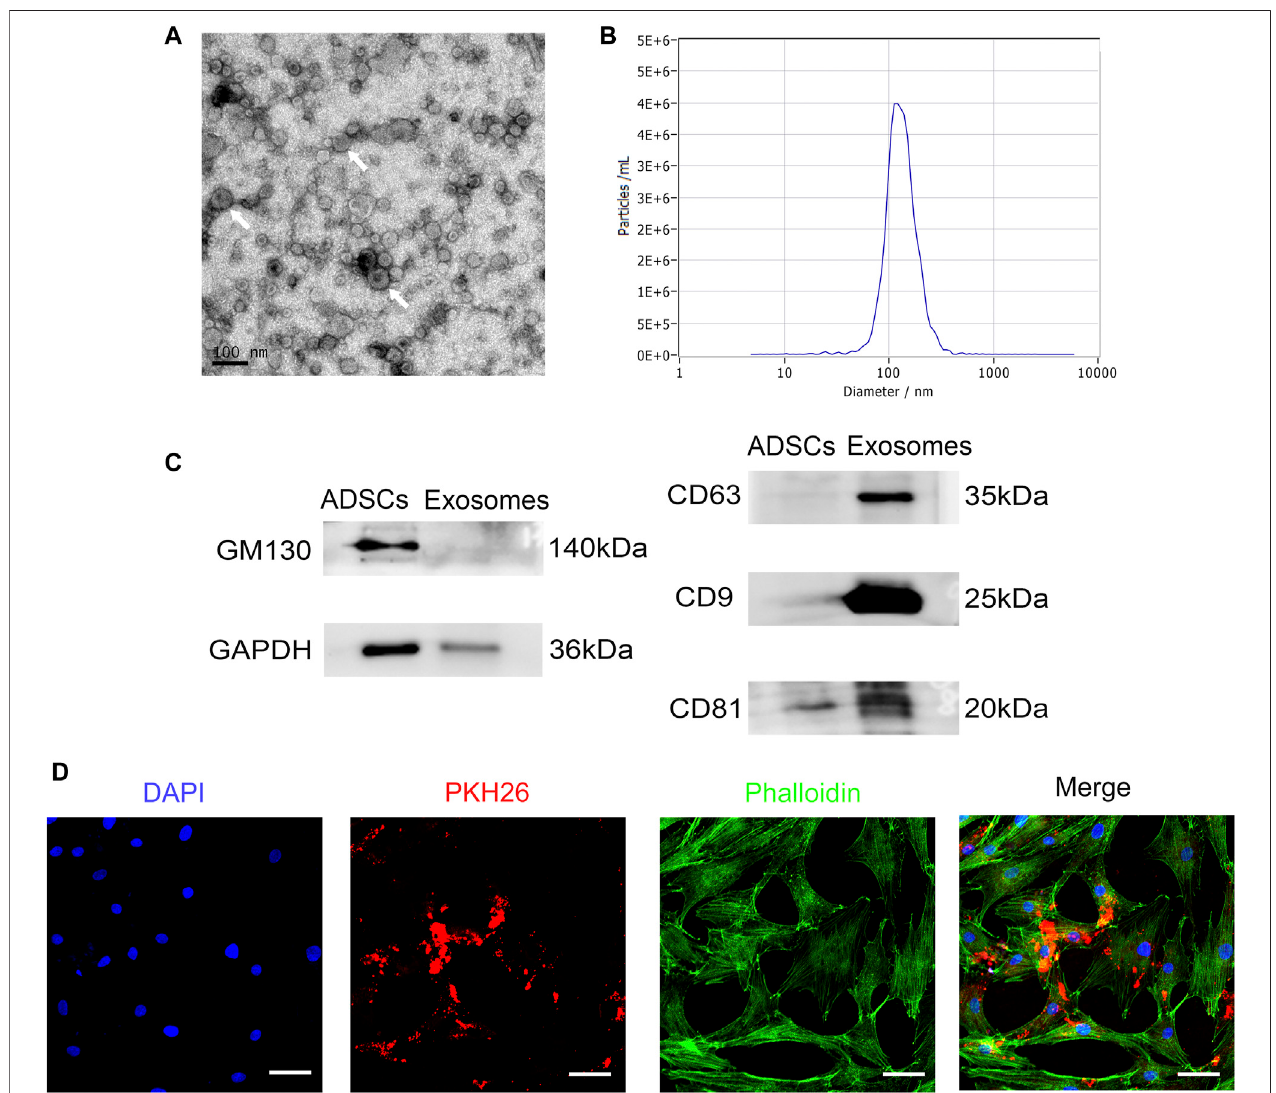
FIGURE 2 | Identi fi cation and internalization of RSC96-Exos. (A) Morphology of RSC96-Exos observed by transmission electron microscopy. Scale bar: 100 nm. White arrows indicate the RSC96-Exos. (B) Measurement of the RSC96-Exos population by nanoparticle tracking analysis demonstrated a single-peaked pattern (127.5 ± 2.1 nm in diameter). (C) Western blot analysis of total protein markers (GM130 and GAPDH) and exosome surface markers (CD63, CD9 and CD81) in ADSCs and RSC96-Exos. (D) Confocal images of ADSCs incubated with 20 μ g PKH26-labeled RSC96-Exos for 24 h. Scale bar: 50 µm.